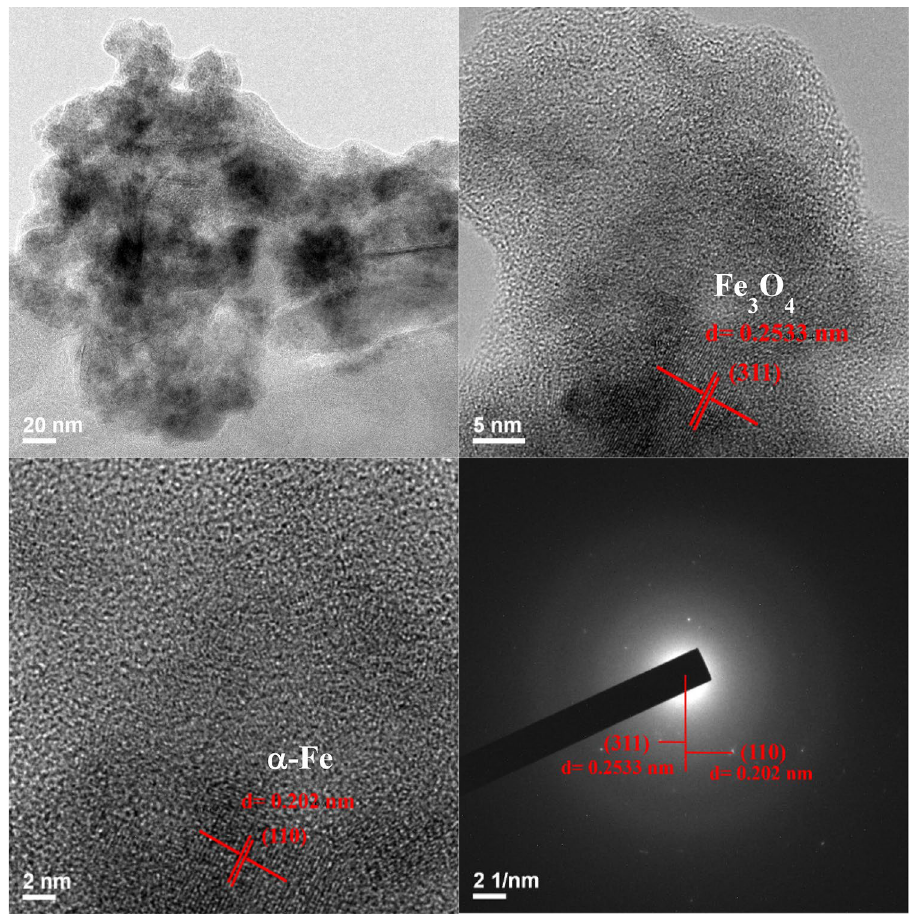
Figure 2. High-resolution TEM and SAED images of Tu–N–SCG–C–A.